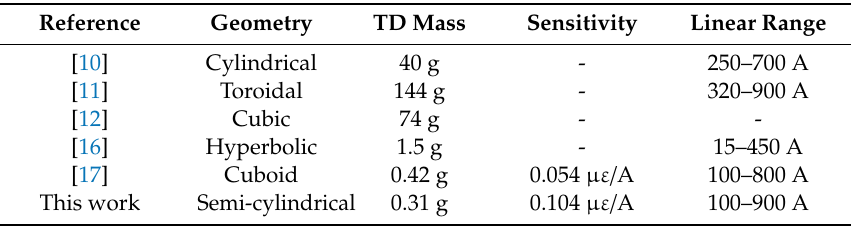
Table 5. Summary of di ff erent